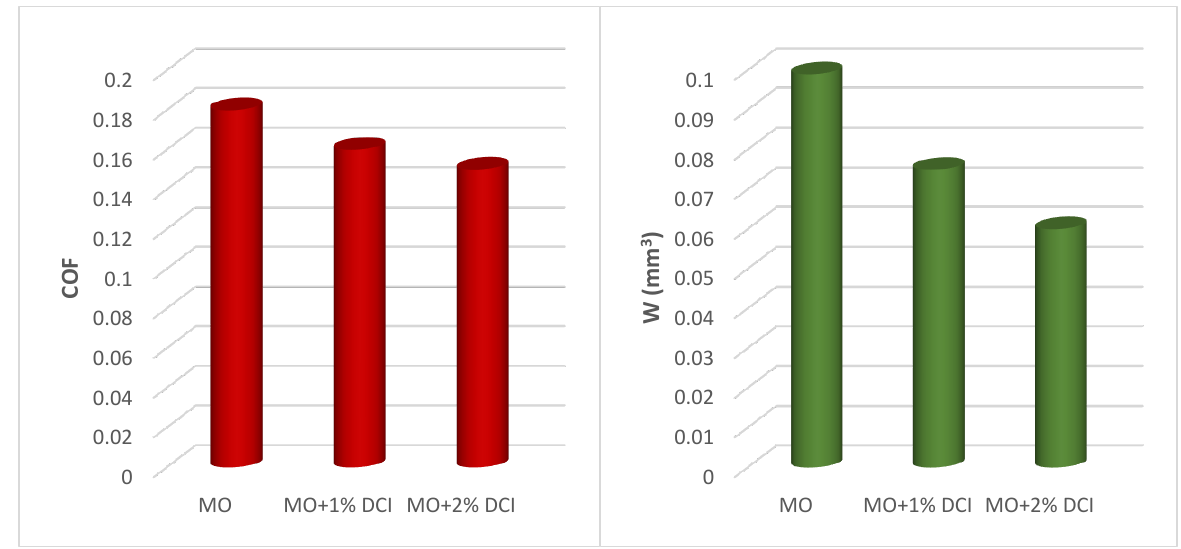
Figure 16. Fiction coefficient and wear volume for different concentrations at sliding velocity of 0.15 m/s.